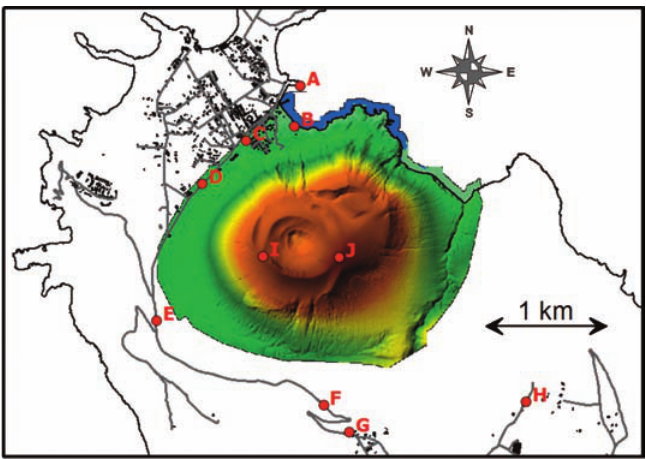
Figure 4. Positions of the GPS points acquired during the August 2008 survey at Vulcano Island (A-J; red circles). Gray lines, main roads; black polygons, buildings; colored shaded relief, the La Fossa cone.